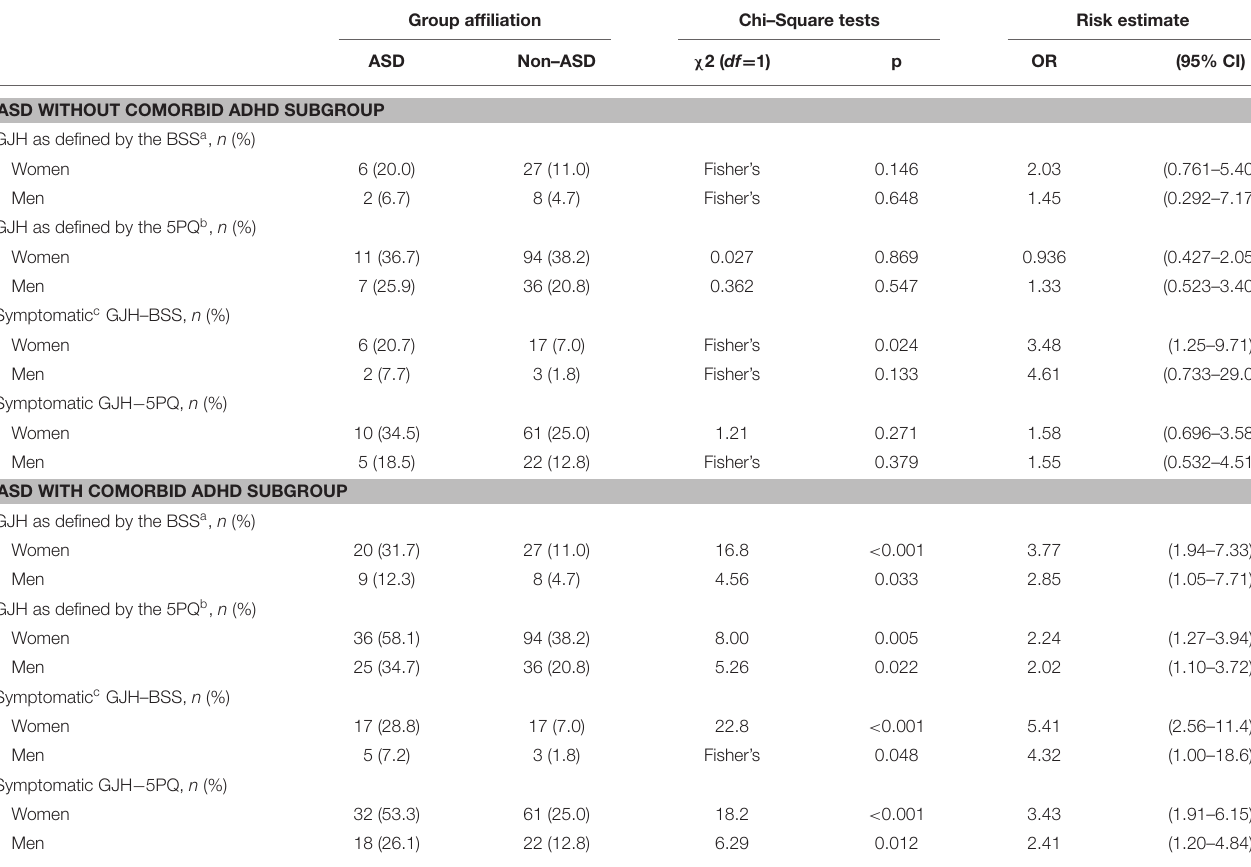
TABLE 5 | Subgroup analyses on ASD with and without comorbid ADHD: Prevalence of generalized joint hypermobility and symptomatic generalized joint hypermobility. Group